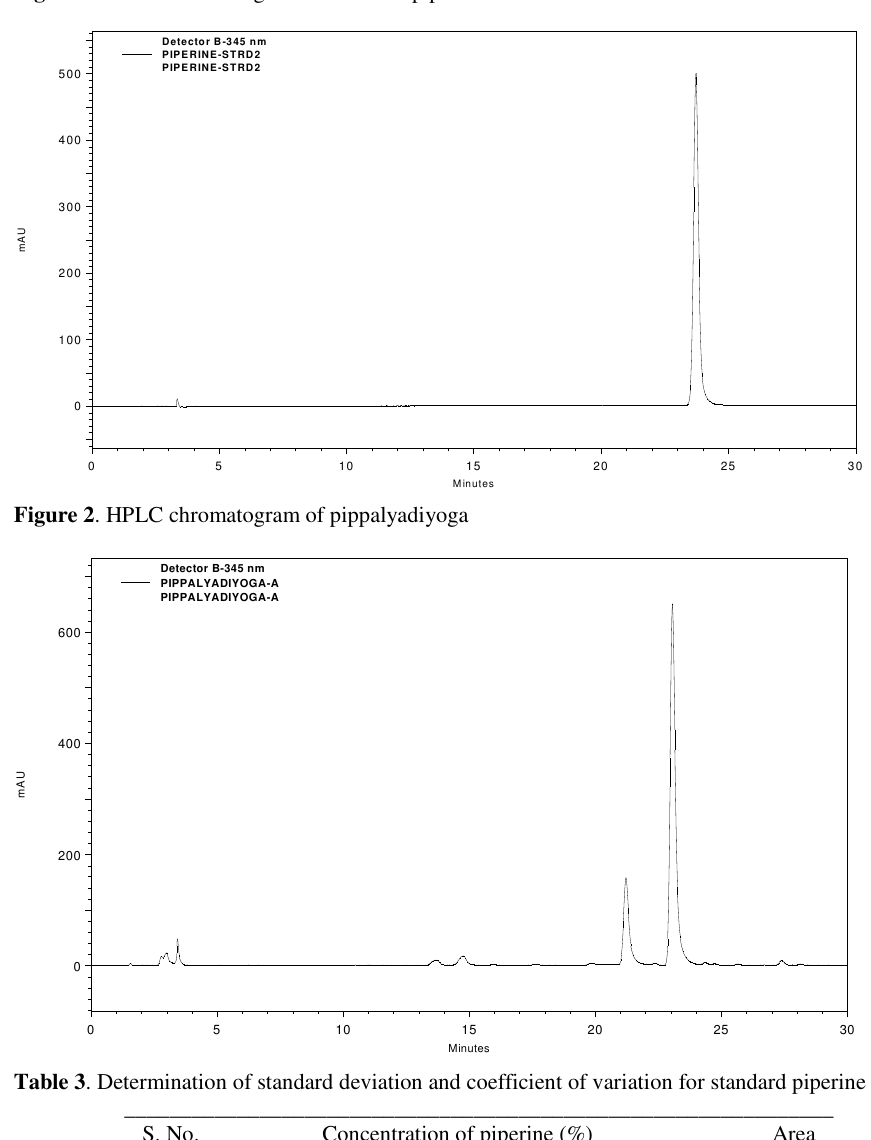
Figure 1 . HPLC chromatogram of standard piperine